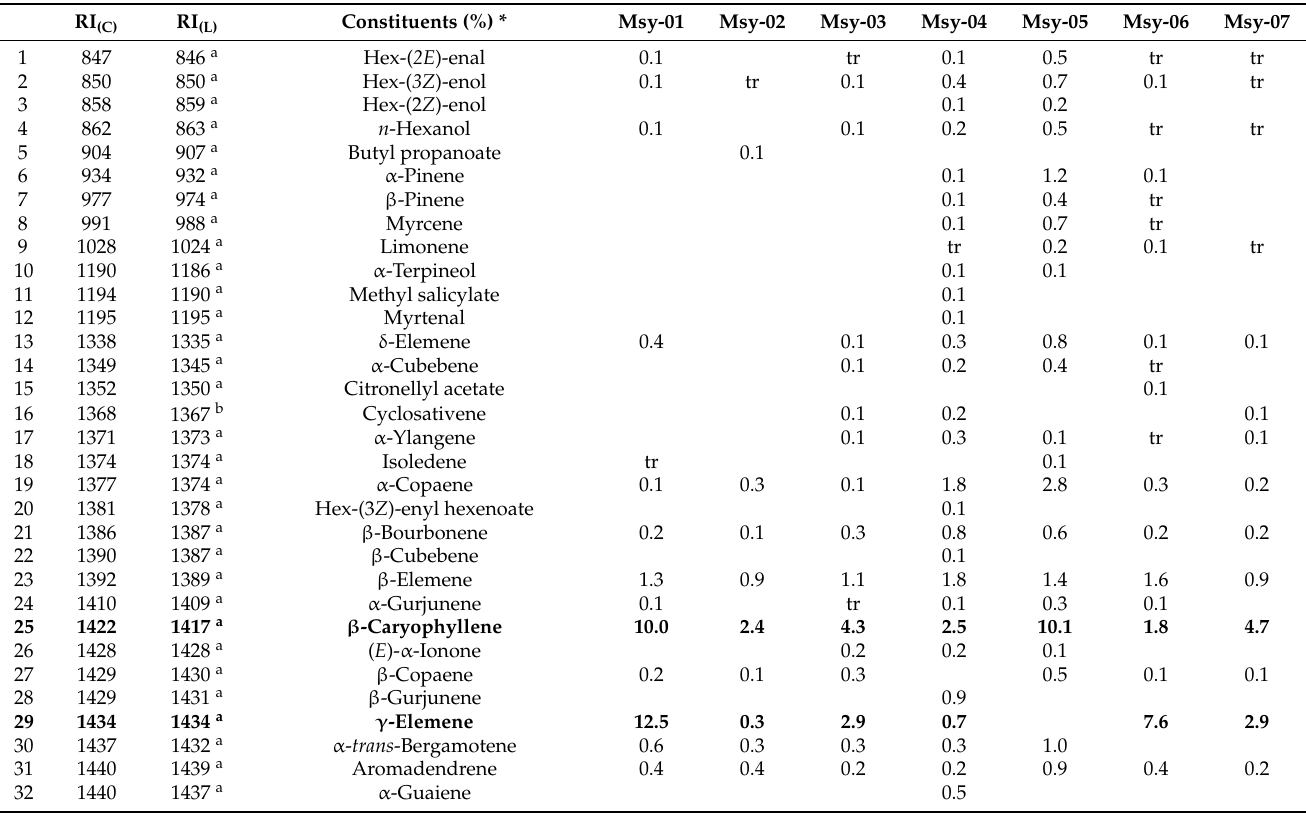
Table 1. Yield and composition of essential oils from Myrcia sylvatica